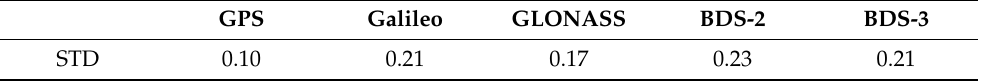
Table 4. The STDs of multi-GNSS code OSBs during the selected period. (ns). GPS Galileo GLONASS BDS-2 STD 0.10